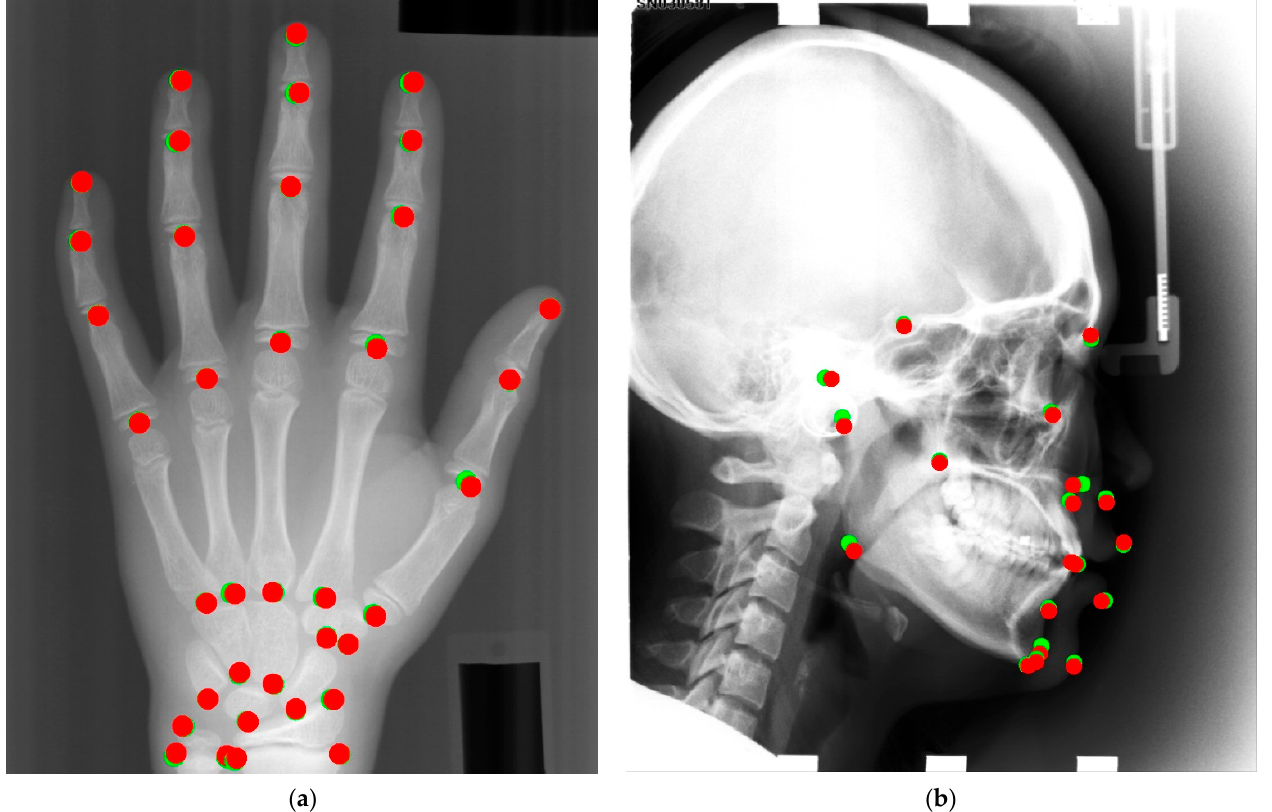
Figure 6. Visualization of landmarks of a sample test image in the Digital Hand Atlas and ISBI 2015 datasets. Red dots are the ground-truth of image, and green dots are the prediction result of U-Net with the hybrid perturbation model. ( a ) Digital Hand Atlas. ( b ) ISBI 2015